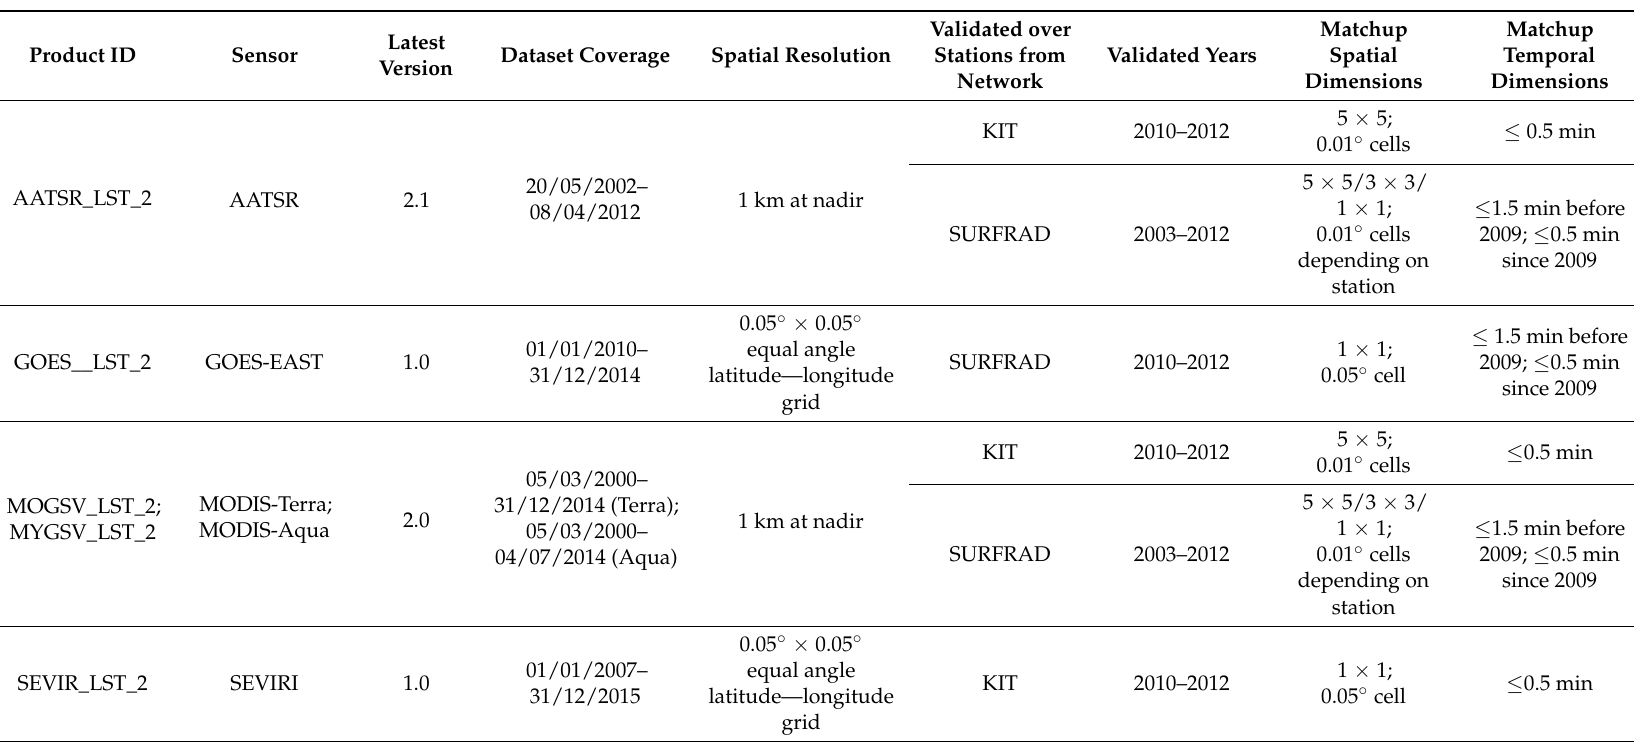
Table 1. Investigated GlobTemperature satellite Land Surface Temperature (LST) products and corresponding